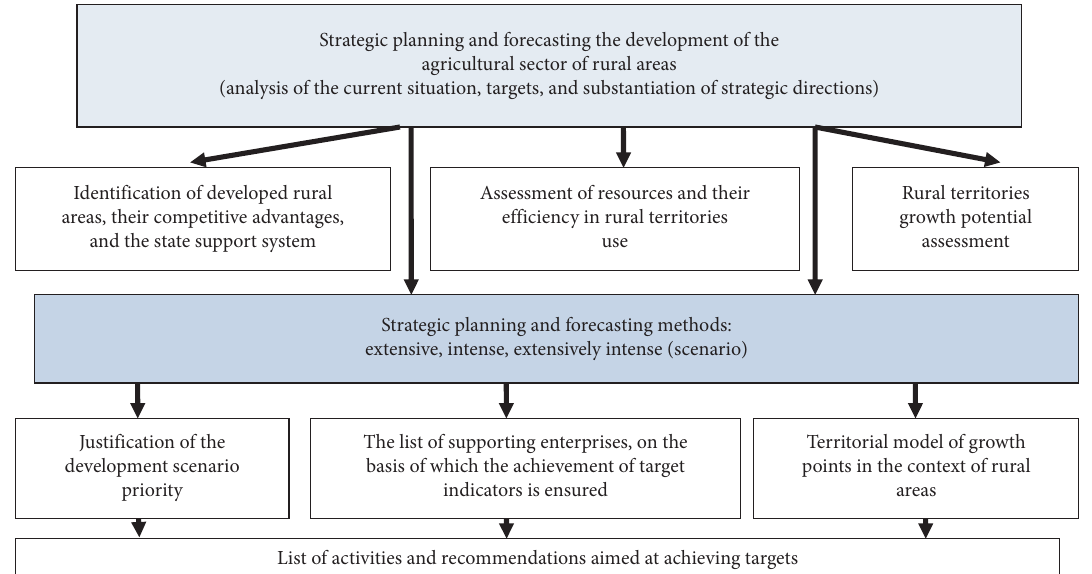
Figure 1: Methodology of strategic planning and forecasting the development of the agroindustrial complex of rural territories (Source: developed by the